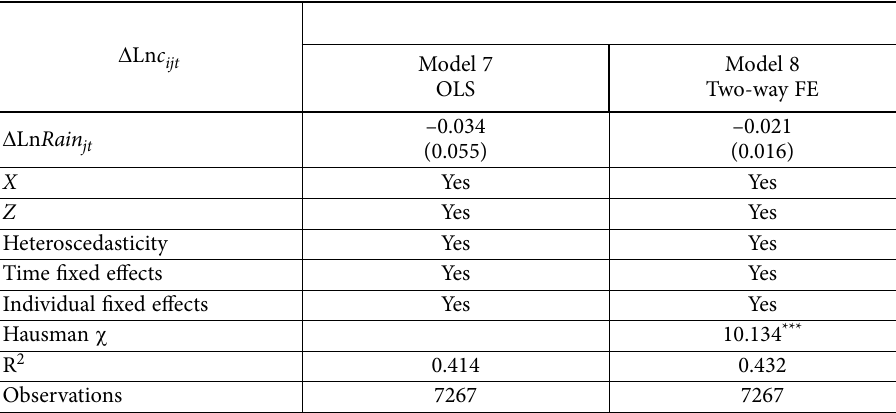
Table 6. Exclusion restriction test of the instrumental